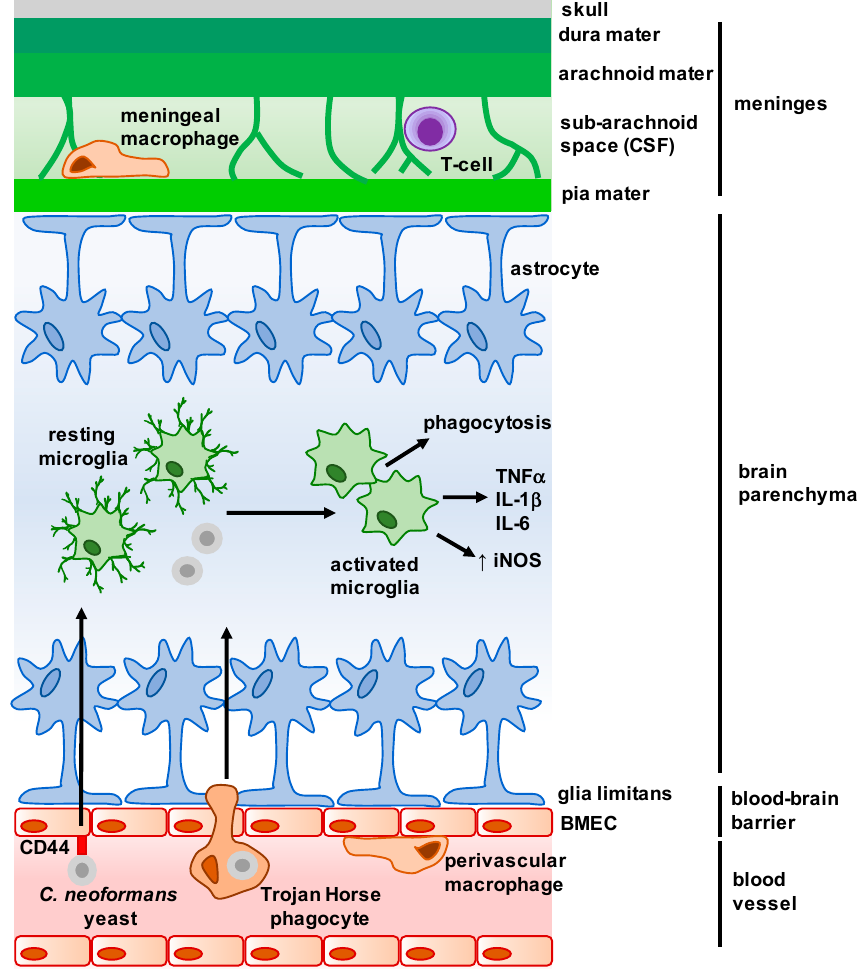
Figure 1. Overview of the main structures and cells of the central nervous system (CNS). The meninges is a complex membrane structure surrounding the brain and spinal cord, and is composed of a series of layers in which several immune cells are found. Cerebrospinal fluid (CSF) flows through the sub-arachnoid space here, and drains into the lymph nodes via lymphatic vessels (not shown). Astrocytes form barriers along the meninges and blood–brain barrier (BBB) and largely control cellular movement into the CNS. Microglia are found within the parenchyma, and exhibit a dendritic morphology when resting. Upon interaction with microbes, microglia activate and appear amoeboid in morphology. C. neoformans enters the parenchyma either as free yeast cells (following interaction with brain microvascular endothelial cells (BMECs)) or within infected macrophages (Trojan Horse phagocytes) from the brain microvasculature. Arrows represent movement of C. neoformans into the brain parenchyma, and resulting activation and cytokine production by microglia.